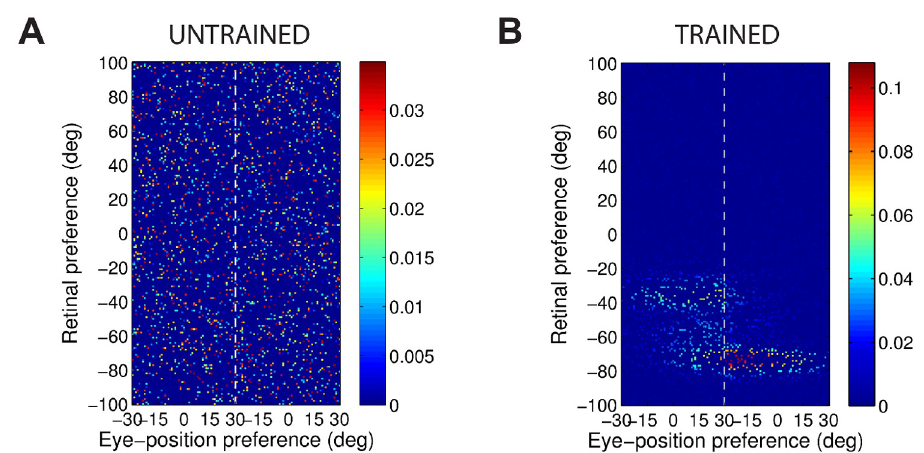
Fig 13. Simulation results showing the strengths of the afferent synapses of a model incorporating a population of sigmoidal modulated input neurons trained with the modified learning rule 16: Delayed postsynaptic trace with anti-Hebbian learning. The figure shows the strengths of the afferent synapses from the input population to output neuron #168 for the untrained (A) and trained (B) model. The output neuron corresponds to the one plotted in Fig 12. In each plot, the afferent synapses have been arranged topographically by the preference of the input neuron for retinal location α and eye-position β . The portion of each plot to the left of the white dashed line corresponds to input i j neurons with positive gain κ j > 0, whilst the portion of each plot to the right of the white dashed line corresponds to those input neurons with negative gain κ < 0. The synaptic weights for this output neuron after training (B) have j approximately the correct structure for a head-centred neuron as shown in Fig